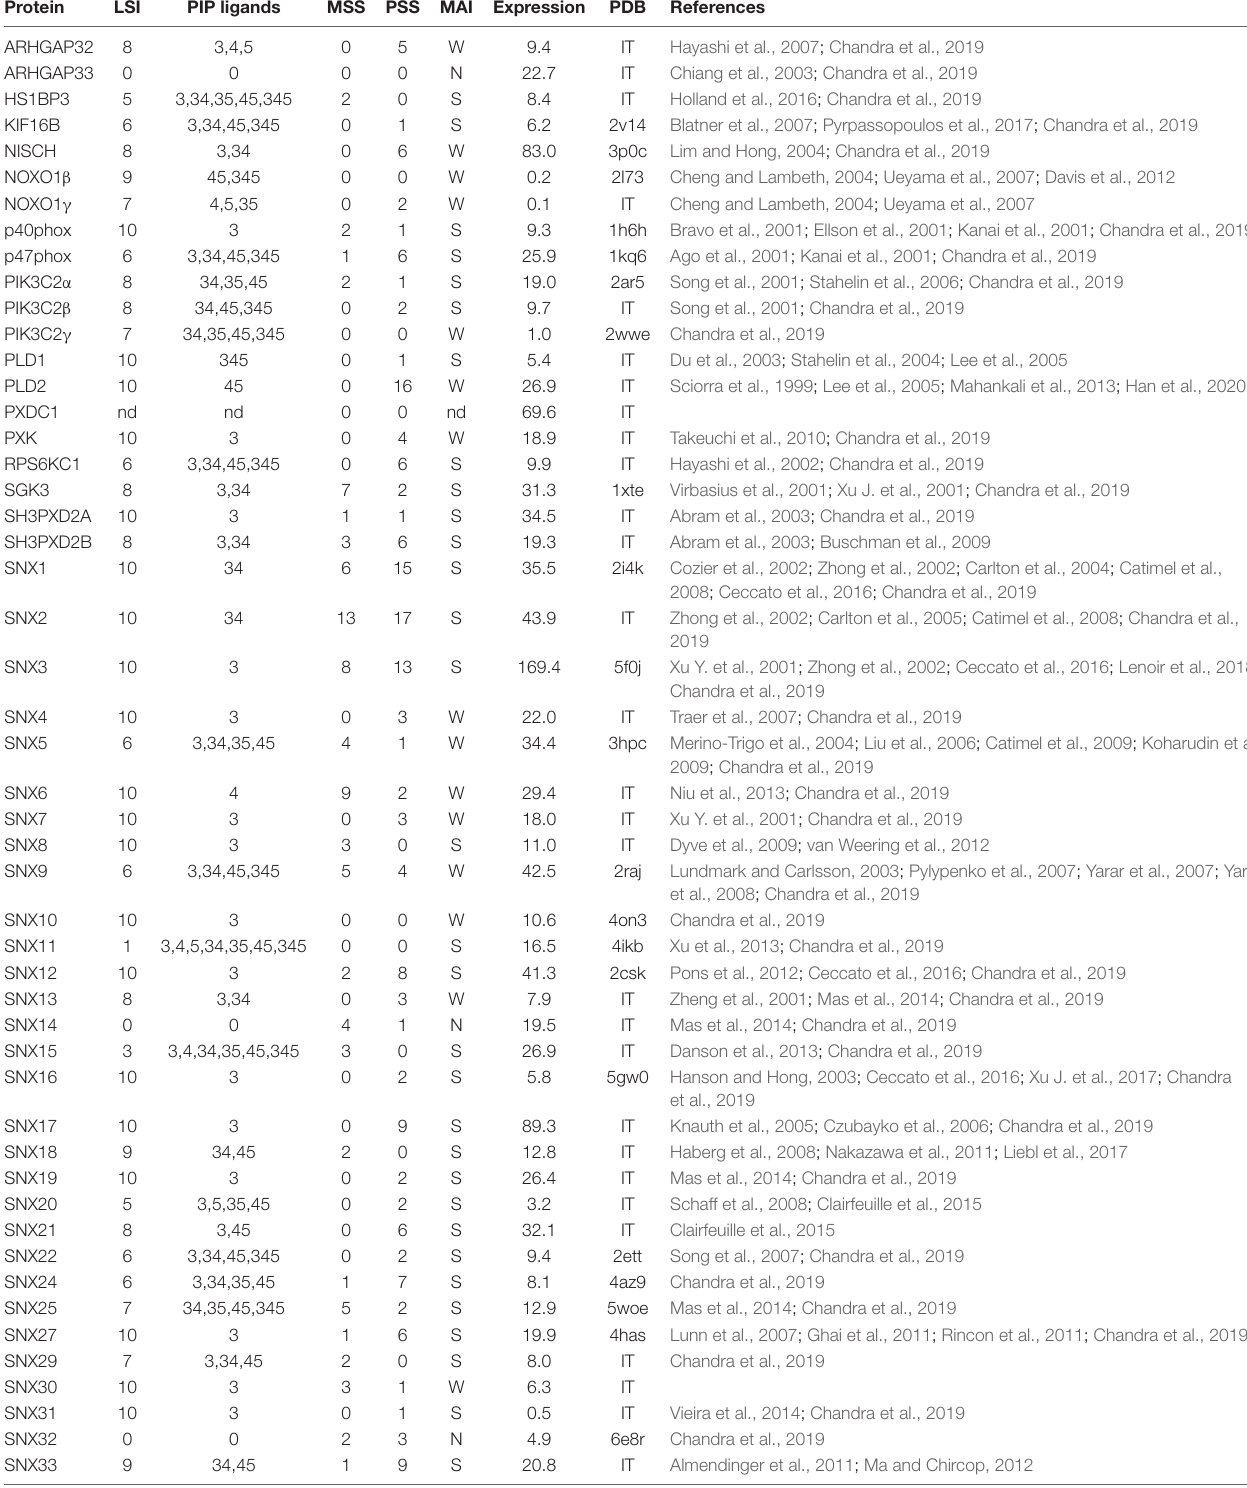
TABLE 1 | Human PX domain